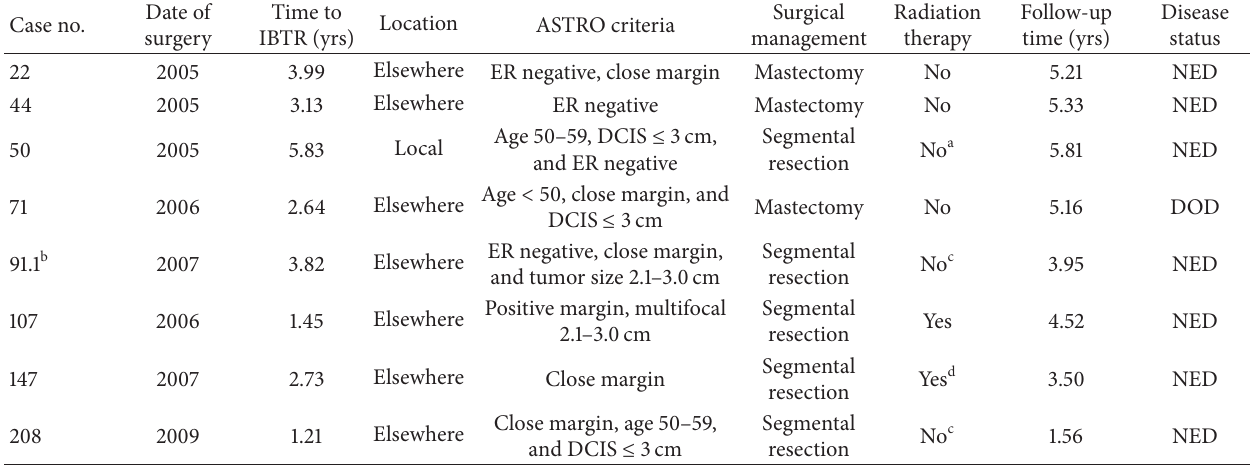
Table 4: Surgical management of ipsilateral breast tumor